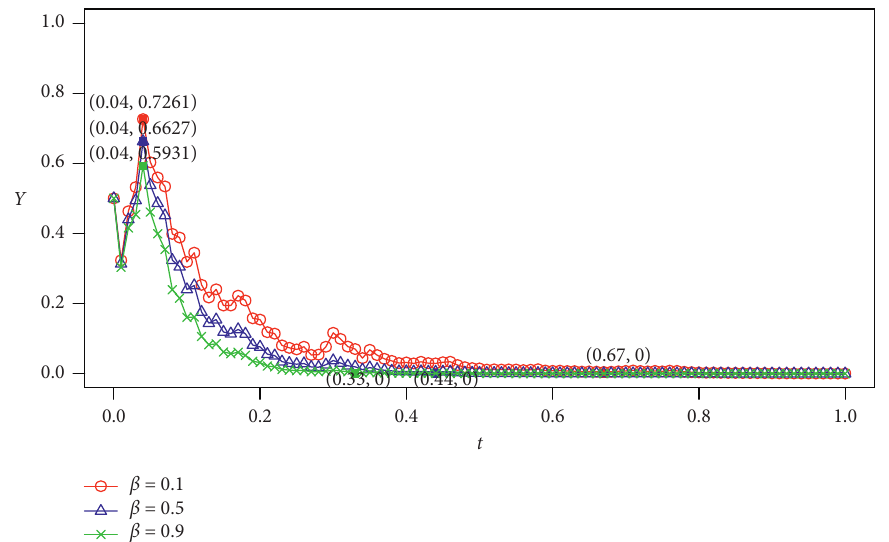
Figure 6: The impact of the degree of punishment β on commercial bank’s strategy